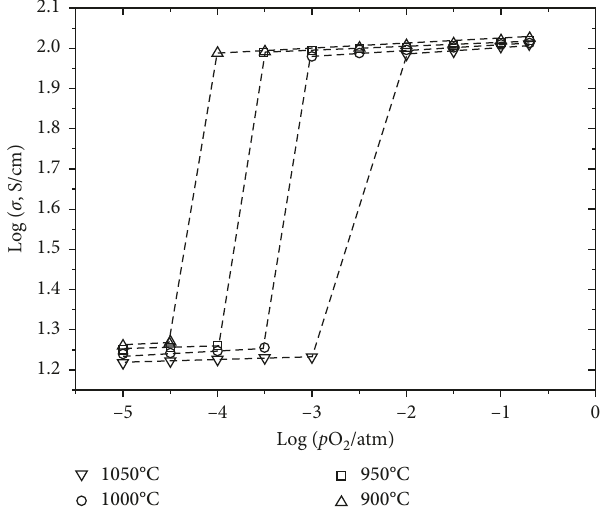
Figure 7: Overall conductivity of YBaCo different temperatures. Points correspond to experimental data and dash lines are guide to eye